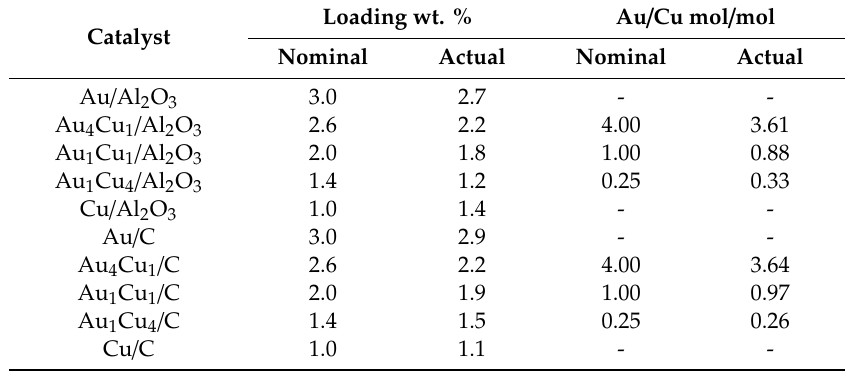
Table 1. Nominal and actual metal loadings obtained by inductively coupled plasma (ICP) analyses. Loading wt. % Catalyst